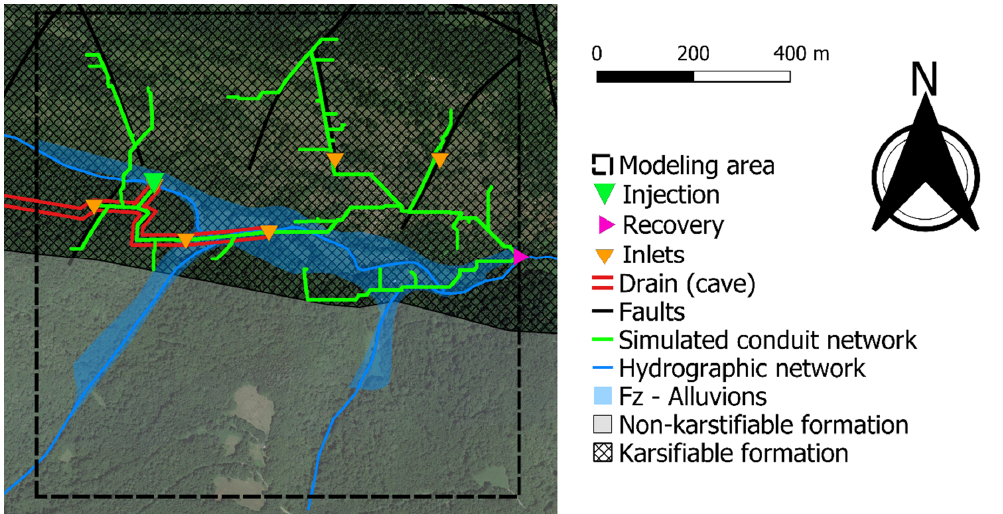
Figure 4. Simulation of a karst conduit network over the downstream part of the Baget watershed using the SKS algorithm.